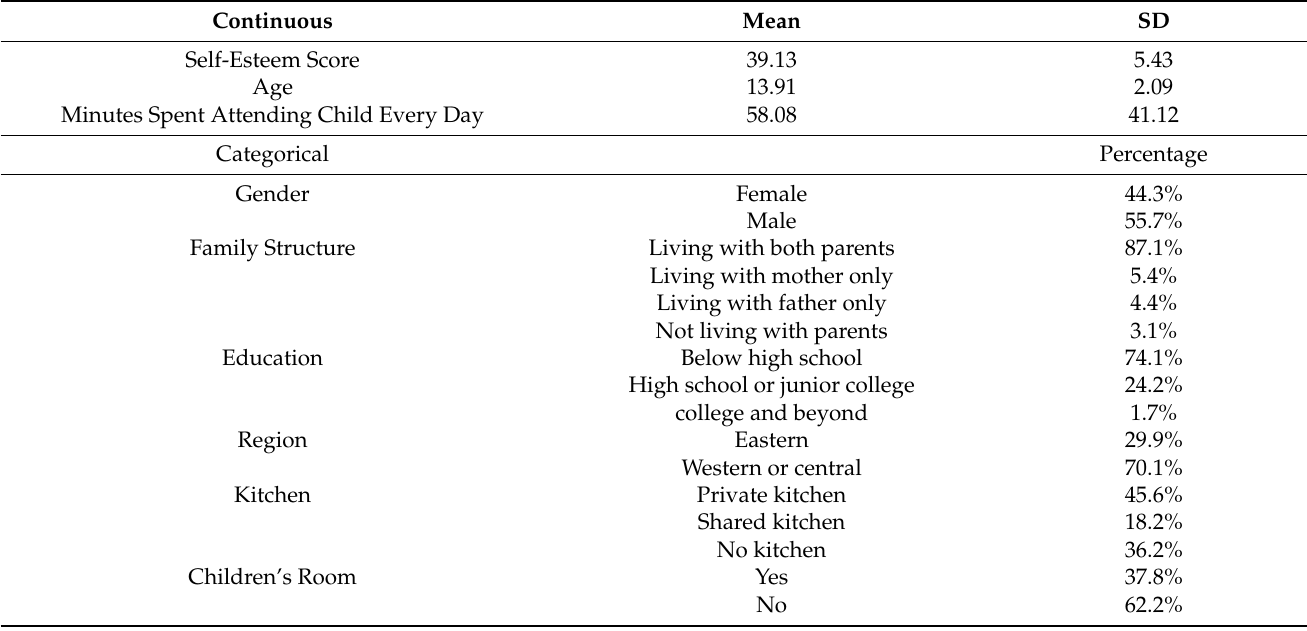
Table 1. Descriptive Statistics of Rural-to-Urban Migrant